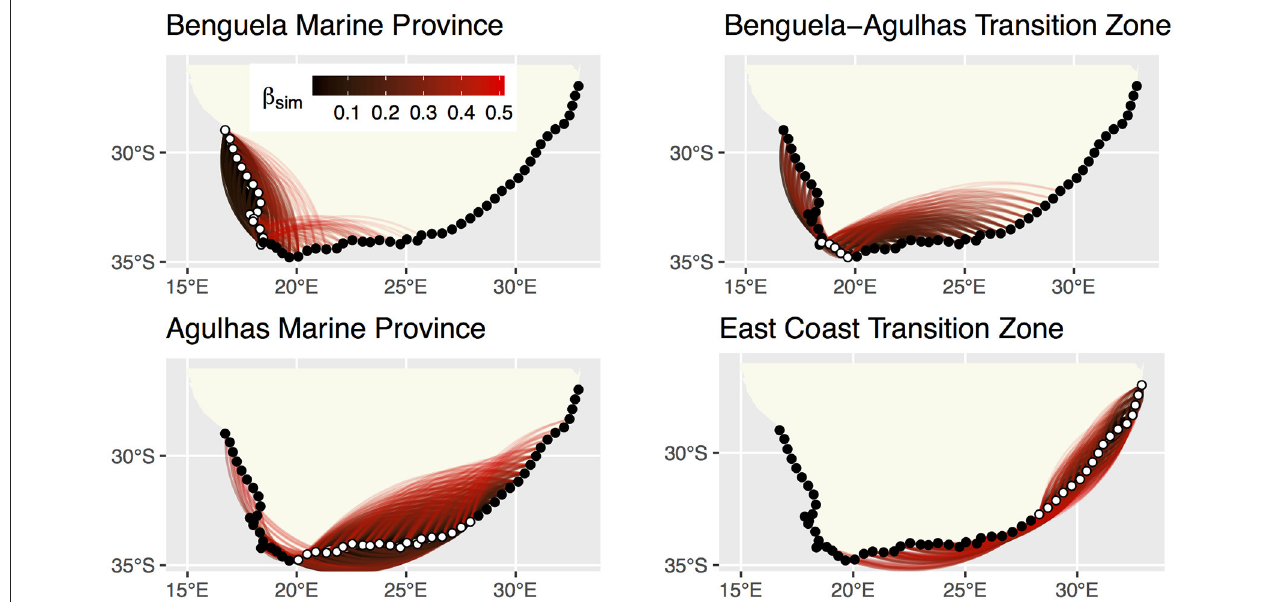
FIGURE 4 | Network graphs of pairwise β sim showing sections that are similar to one-another in species composition. Dissimilarity indices range from >0.0 to 0.5 (possible dissimilarities range from 0.0 to 1.0). The 58 sections in Appendix A (Supplementary Materials) appear as dots at the vertices of the network graph, with those belonging with the “active” bioregion shown in white. The pairwise dissimilarities are shown by the colored lines, with blacker lines indicating lower dissimilarity indices (species composition more similar) and redder ones higher dissimilarity indices (species composition more dissimilar).